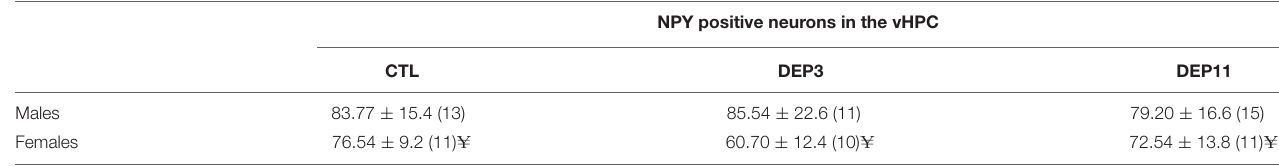
TABLE 2 | Number of positive NPY-immunoreactive cells in the ventral hippocampus (vHPC) of adolescent male and female rats, kept with the mother – control (CTL) or maternally deprived on postnatal days 3 (DEP3) or 11